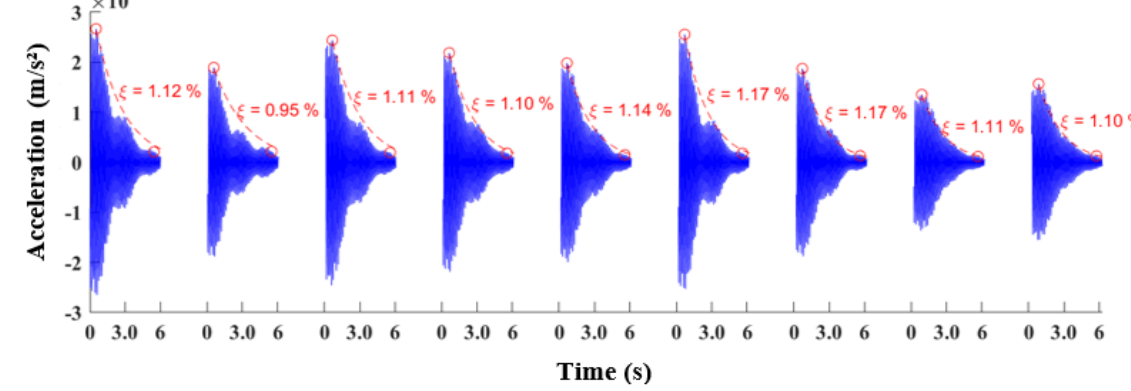
Figure 9. Example of the acceleration graph in the time domain filtered at the third